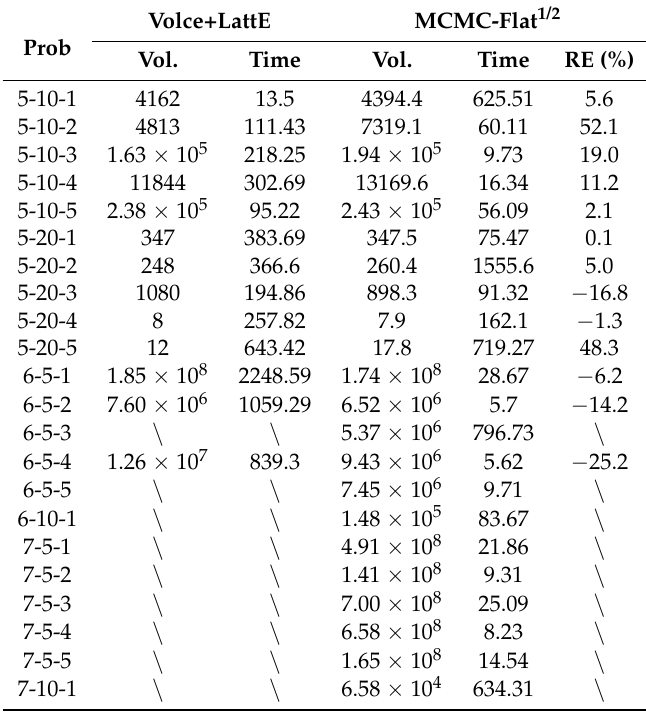
Table 5. Comparison of Volce+LattE and MCMC-Flat 1/2 on convex